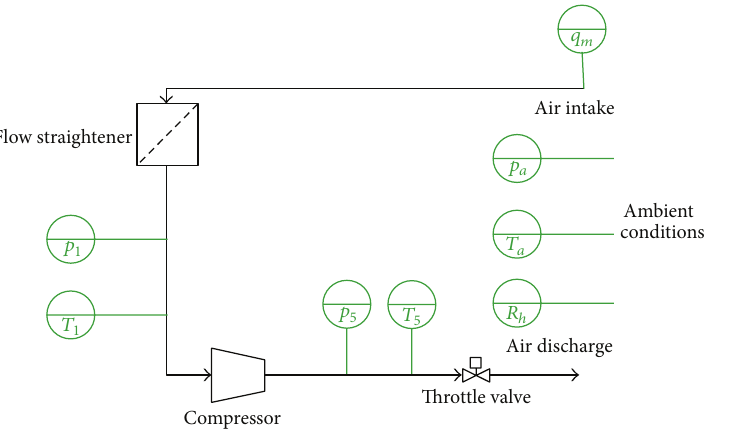
Figure 6: Layout of the test stand.